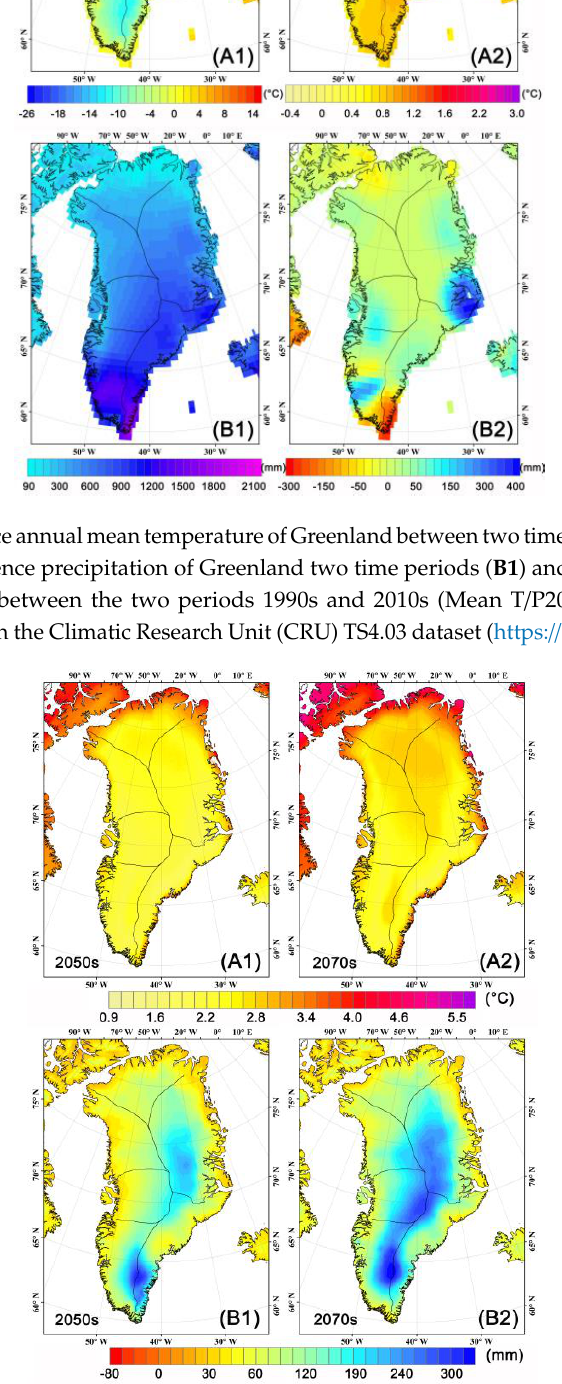
Figure 6. The di ff erent increases of annual mean temperature of Greenland under the RCP4.5 in the 2050s ( A1 ) and 2070s ( A2 ), and the projected increases of annual precipitation of Greenland under RCP4.5 in 2050s ( B1 ) and 2070s ( B2 ), were generated from the differences between the two periods